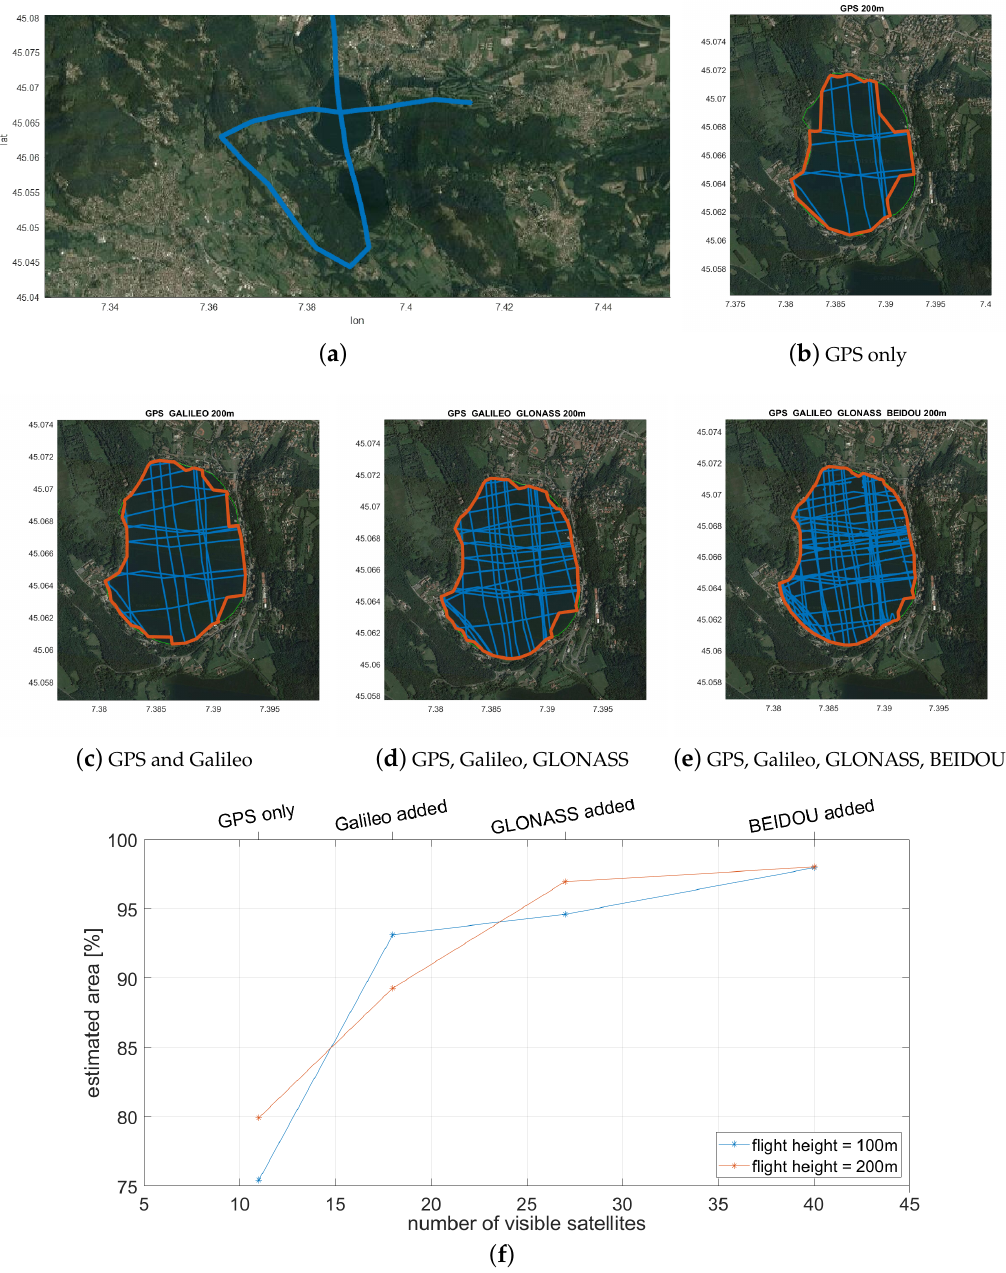
Figure 9. Simulation results of multi-GNSS reflections: ( a ) the sensor trajectory considered, ( b – e ) the specular points lines using the different GNSS constellations, ( f ) the ratio between the estimated and the real area of the Northern Avigliana lake versus the number of satellites in view, two different heights of the sensor are